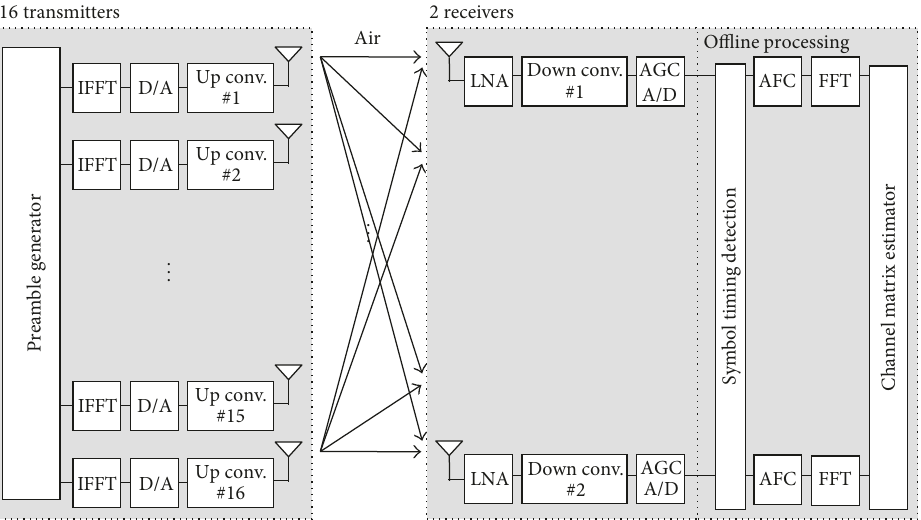
Figure 6: Configuration of MIMO-OFDM testbed.